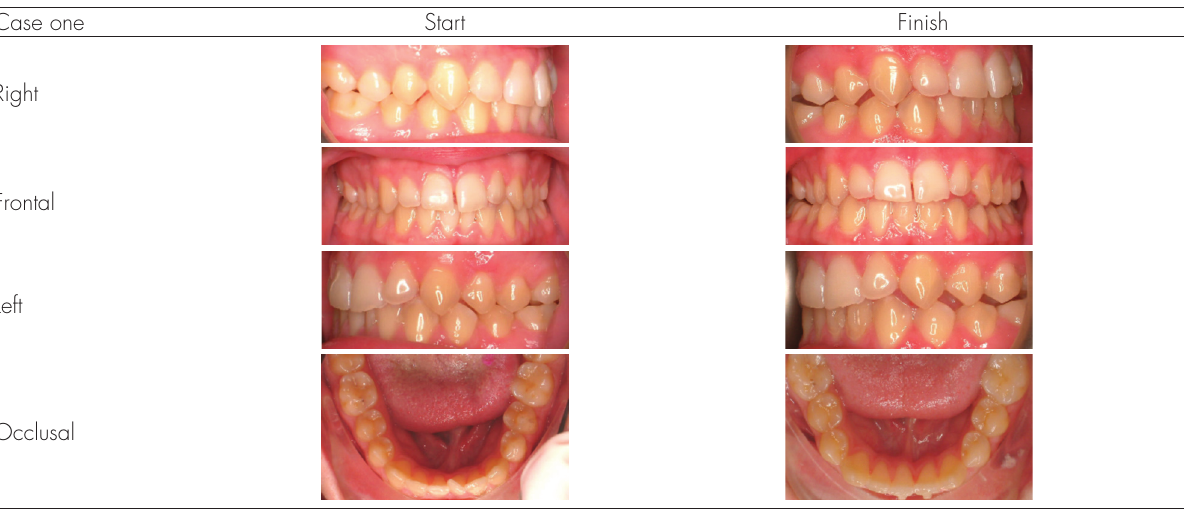
Figure 2a. Case one of five cases, each illustrated with eight images – four Start and four Finish. The four images are: right side; frontal; left side and occlusal lower.